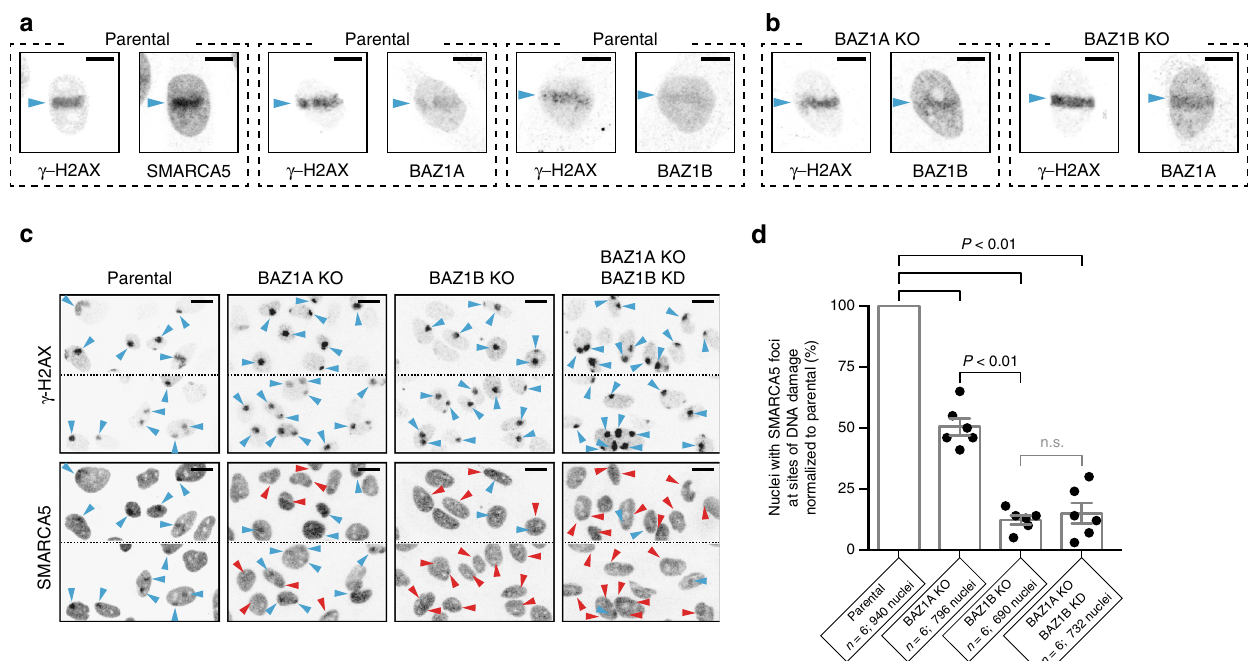
Fig. 2 BAZ1A and BAZ1B accumulate independently to sites of DNA damage and recruit SMARCA5. a Accumulation of endogenous SMARCA5, BAZ1A, and BAZ1B at sites of laser micro-irradiation in parental HeLa cells. The genetic background is indicated on top of the panels. Regions of DNA damage are identi fi ed by the presence of γ -H2AX (histone variant H2A.X phosphorylated on S139), and are labeled with cyan arrowheads . Images are representative of at least fi ve individual irradiated cells. Scale bar , 10 μ m. b Accumulation of endogenous BAZ1A and BAZ1B at sites of laser micro-irradiation in genome edited BAZ1A -KO and BAZ1B -KO cells. Scale bar , 10 μ m. c Accumulation of endogenous SMARCA5 at sites of DNA damage in cells subjected to UVC irradiation through a 5 μ m porous membrane 47 . Each square panel is composed of two rectangular representative images showing 6 – 10 nuclei. The genetic